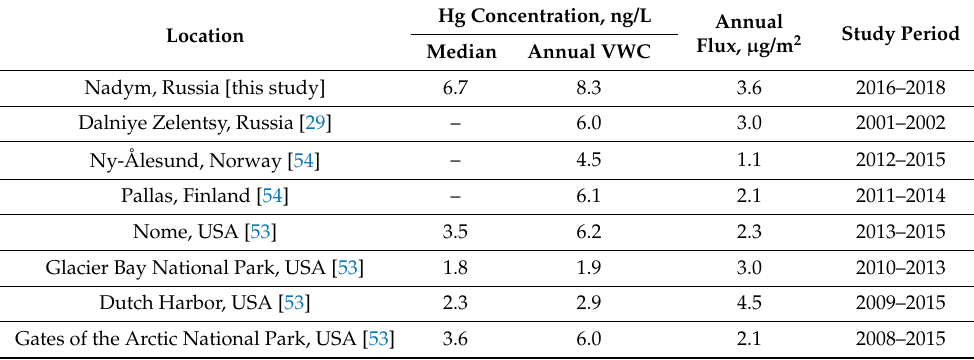
Table 3. Concentrations and fluxes of mercury in wet atmospheric precipitation in Nadym and other remote Arctic